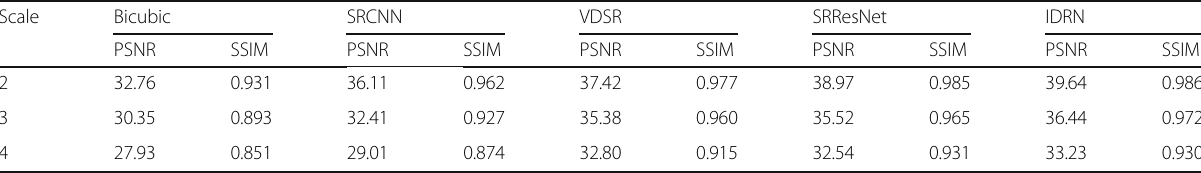
Table 3 The comparison of different SR algorithms Scale